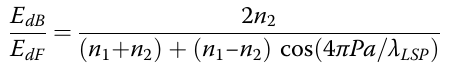
Table 3 listed the C SB / C SF of structure B obtained by Eq. (4) with different P coefficients. One can see that